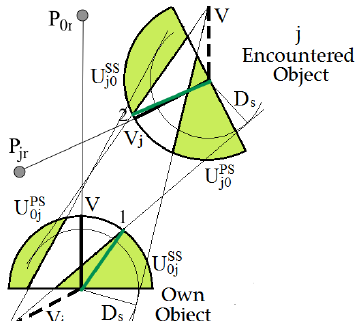
Figure 3. The method of determining the acceptable strategy sets of the own object U 0 j = U 0 jPS ∪ U 0 jSS and the j th encountered object U j 0 = U j 0 PS ∪ U j 0 SS for the port side (PS) and starboard side (SS). In this figure, P 0 r is the turning point of the rhumb line of the own object, P jr is the turning point of the rhumb line of the encountered object, 1 is a safe maneuver for changing the course of the own object and 2 is a safe maneuver for changing the course of the encountered object.